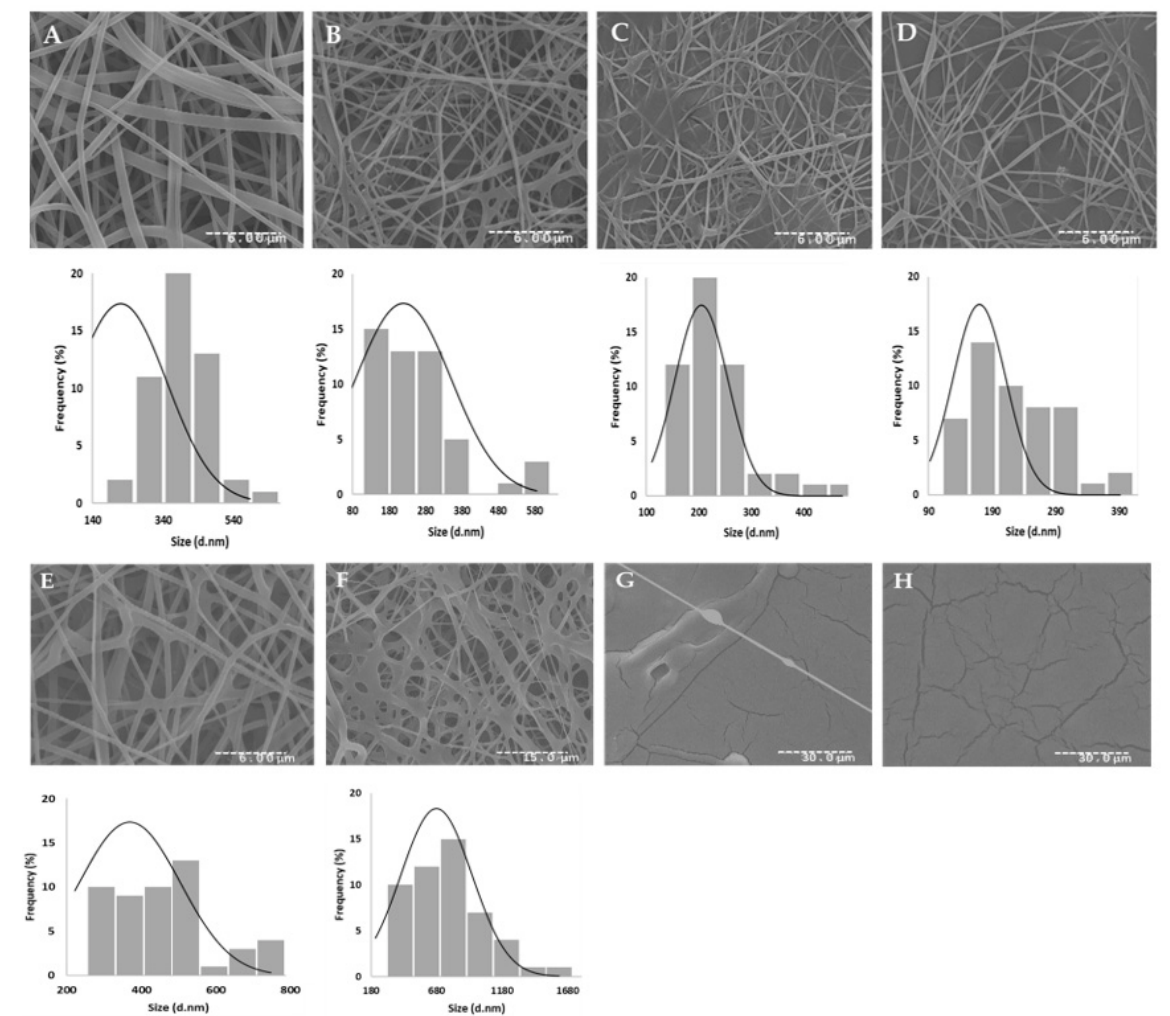
Figure 5. SEM analysis of the nanofibers produced: ( A )—W 5/95; ( B )—W 20/80; ( C )—W 40/60; ( D )—50/50; ( E )—NADE 5/95; ( F )—NADES 20/80; ( G )—NADES 40/60; ( H )—NADES 50/50, and the corresponding histograms of the diameter distribution obtained from ImageJ software.